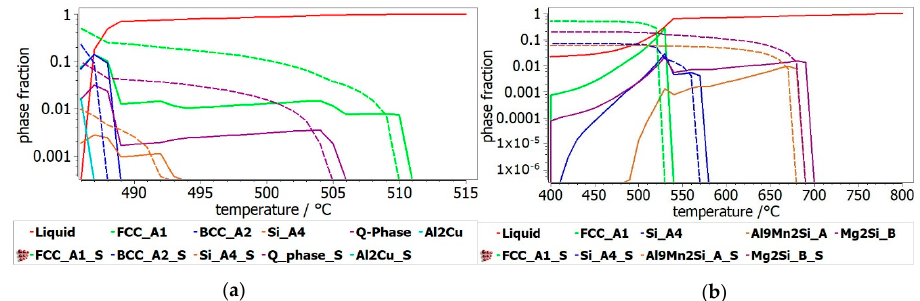
Figure 8. Scheil–Gulliver solidification diagrams for ( a ) Al 3.4 Cu 0.5 Si 0.2 Zn 0.5 Mg 0.2 alloy and ( b ) Al 3 Mn 0.2 Zn 0.3 Mg 0.7 Si 0.8 alloy.